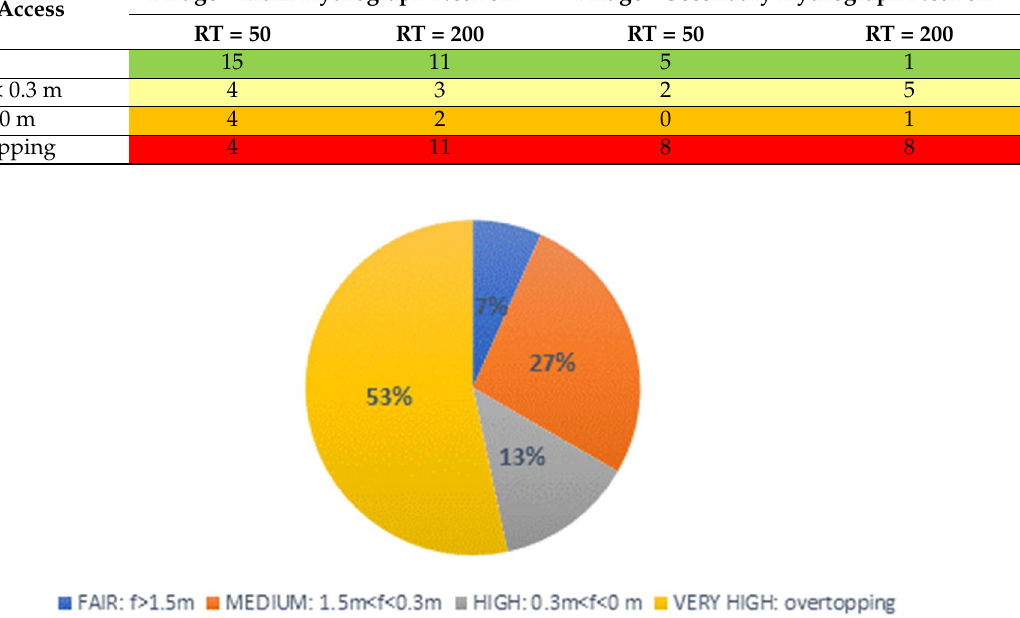
Table A2. Vulnerability levels referring to the freeboard for access embankments for RT = 50 and RT = 200. Vulnerability with Respect to Freeboard of